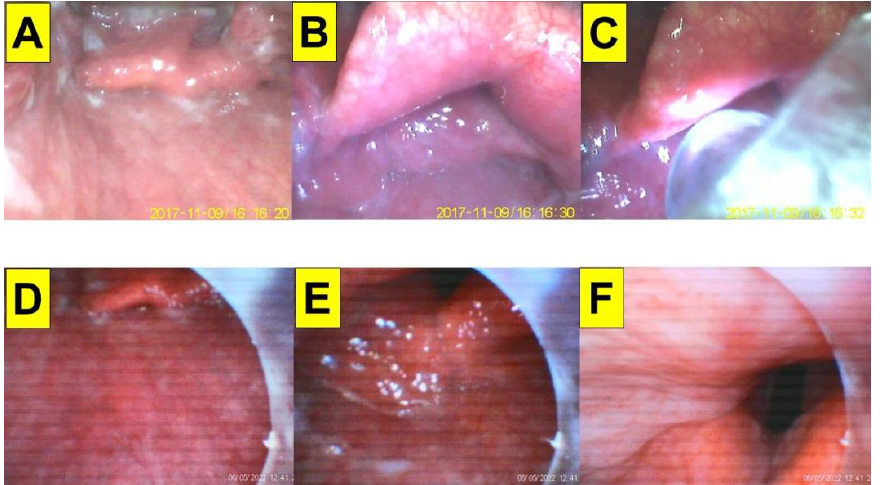
Figure 8. Application of video-twins technique in a morbidly obese patient (a 42-year-old man with a BMI 42.0 kg/m 2 ) underwent genitourinary surgeries. Mallampati class III and Cormack-Lehane laryngoscopic view was grade 2b: ( A – C ) videolaryngoscopic views; and ( D – F ) views from intubating stylet. Intubation time was 10 s. (also see the Supplementary Materials — Videos S12 and S13). Intubating devices: UE and Trachway.